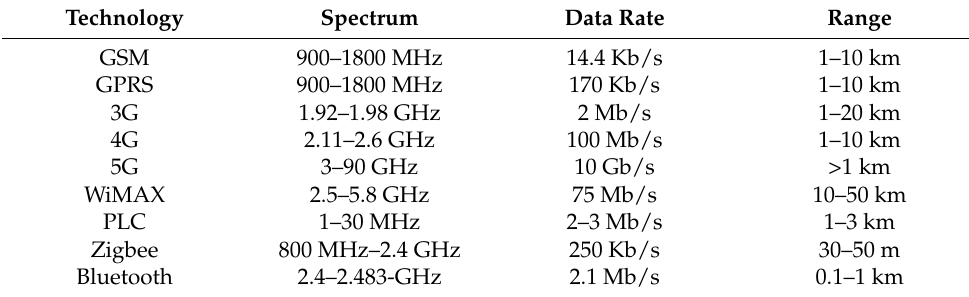
Table 3. Communication technologies in a microgrid.